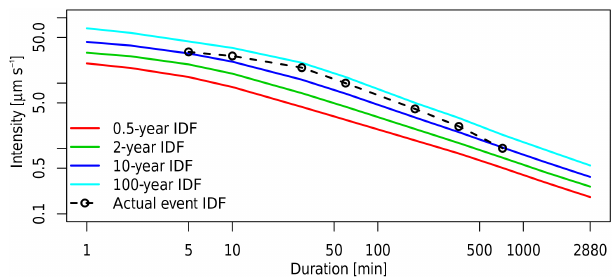
Figure 3. The IDF curve for an extreme event in comparison to the regional IDF curves for 0.5-, 2-, 10- and 100-year return periods, respectively (based on Madsen et al.